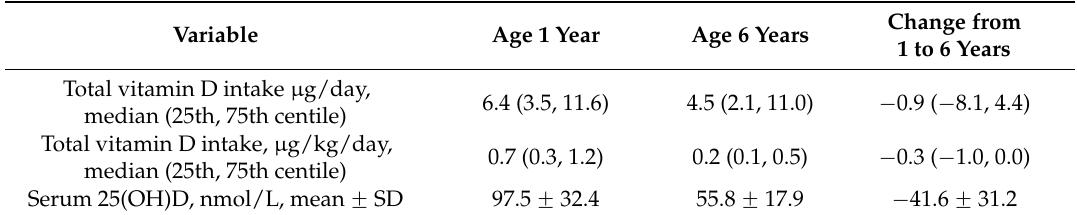
Table 3. Vitamin D intake and status of children with vitamin D status measured at two time points